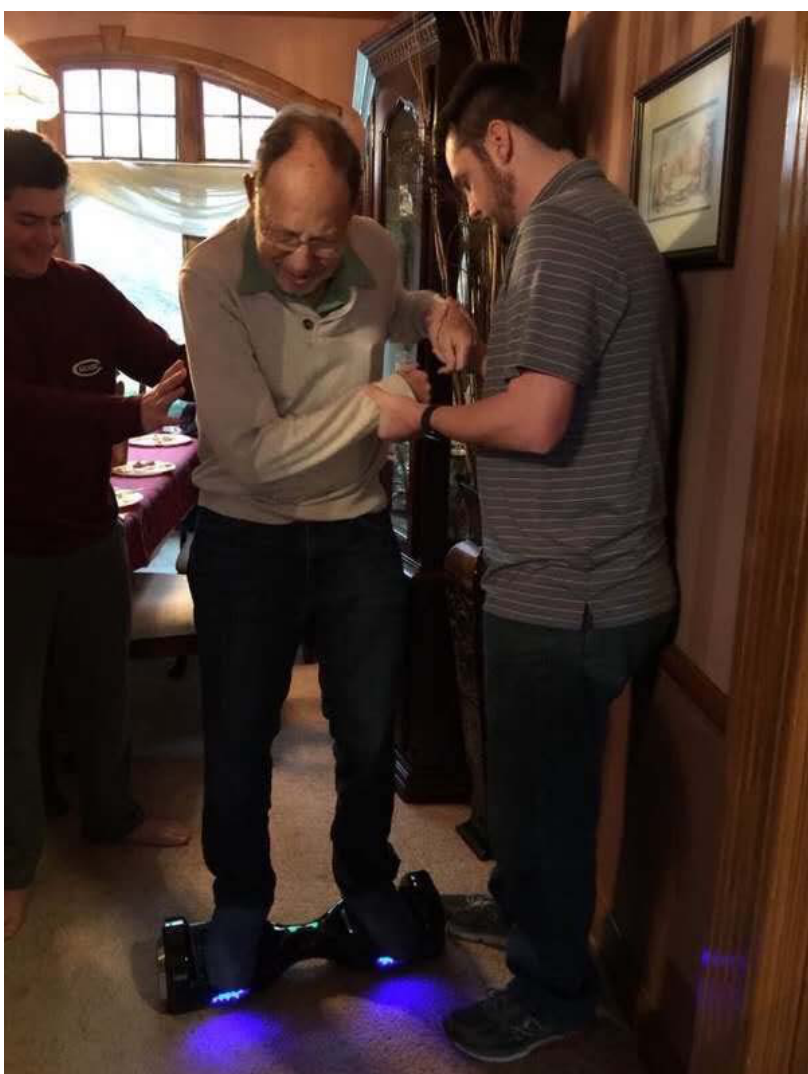
Figure 2. Michael was trying Hoverboard on 24 December 2017 (Photograph courtesy of Karen Bogan).